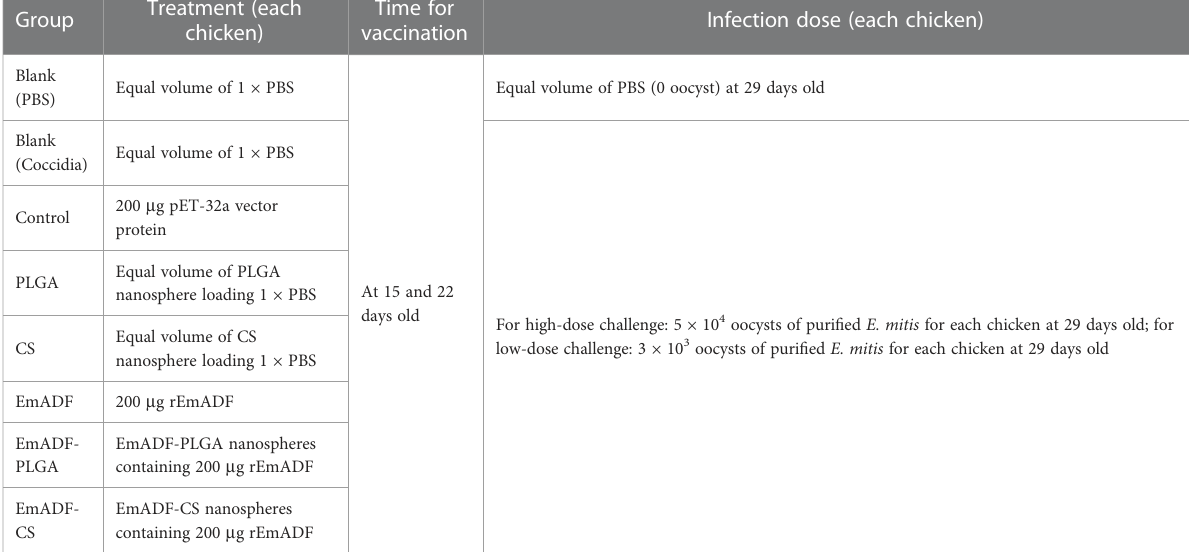
TABLE 1 Group assignment and immune procedure.